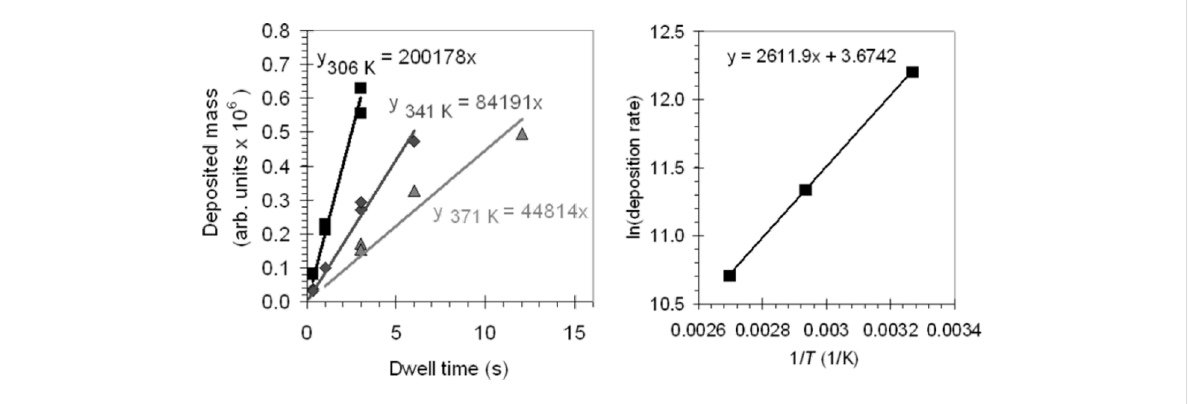
Figure 3: (a) The average deposited mass per dot as a function of dwell time and substrate temperature. The dots are written with spot 9. (b) The Arrhenius plot (the natural logarithm of the deposition rate as a function of the inverse of the temperature) constructed from the data in (a).